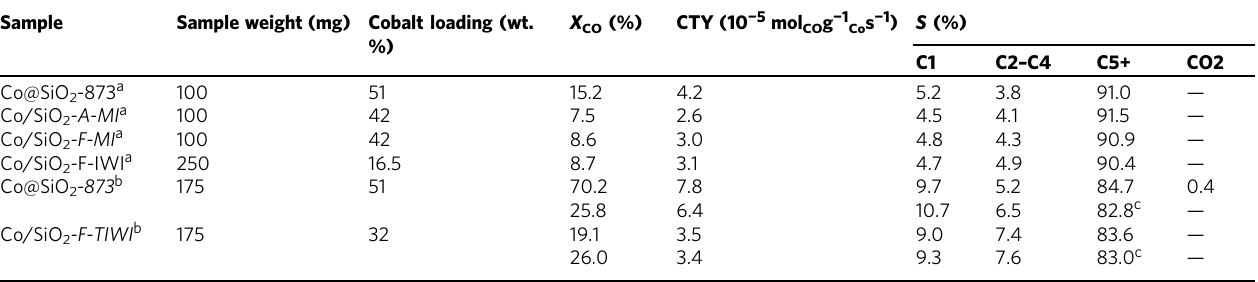
Table 3 Catalytic performance of Co@SiO 2 - 873 and Co/SiO 2 catalysts prepared using conventional methods